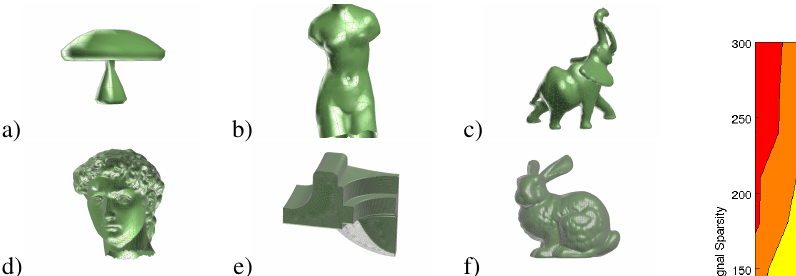
Figure 3: Meshes used in our experiment. (a) Mushroom. (b) Venus. (c) Elephant. (d) David’s Head. (e) Fandisk. (f) Stanford Bunny.